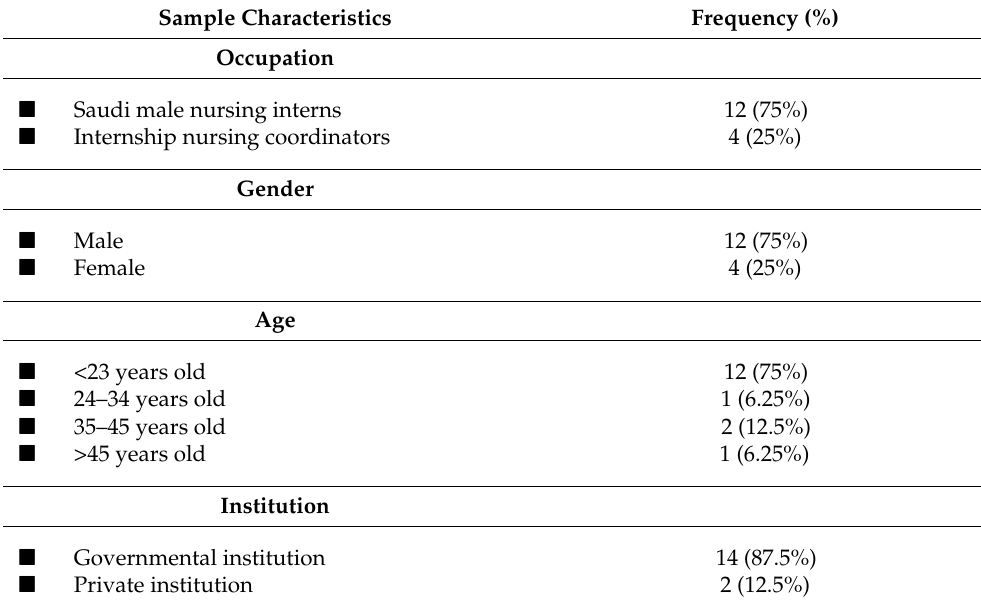
Table 1. Characteristics of study